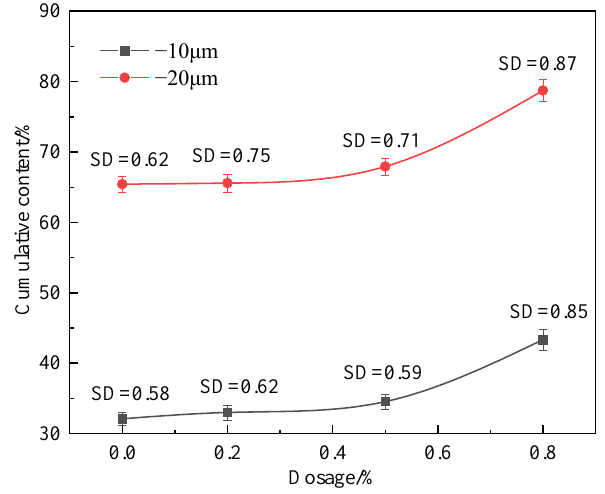
Figure 3. Grinding products −10 μm and −20 μm content.